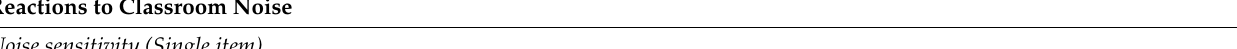
Table A1. Full Questionnaire used in Study